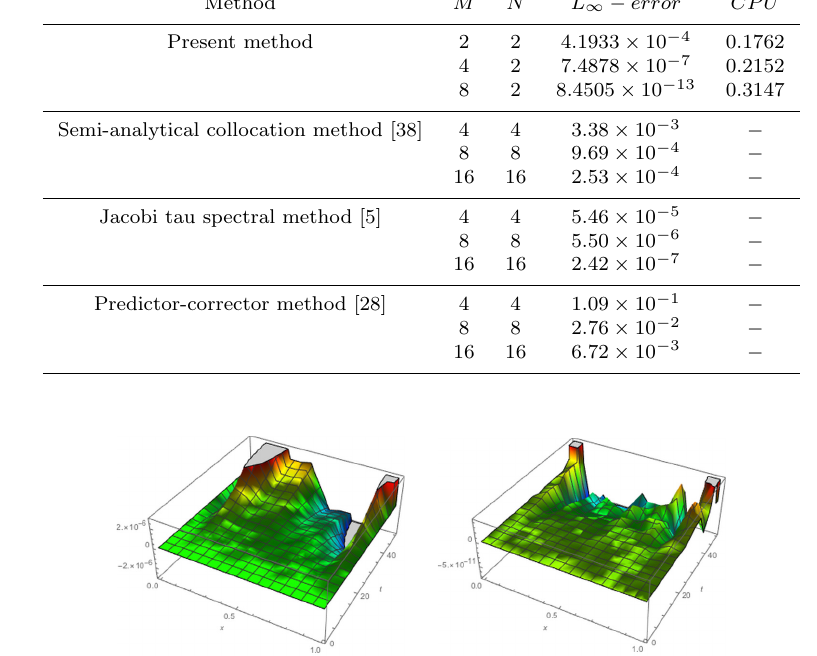
subject to the initial conditions u ( x, 0) = 0 , u t ( x, 0) = 0 , x ∈ [0 , 1] and the boundary conditions u (0 , t ) = 0 , u (1 , t ) = t 2 sin(1) , t > 0 , where f ( x, t ) = (cid:16)